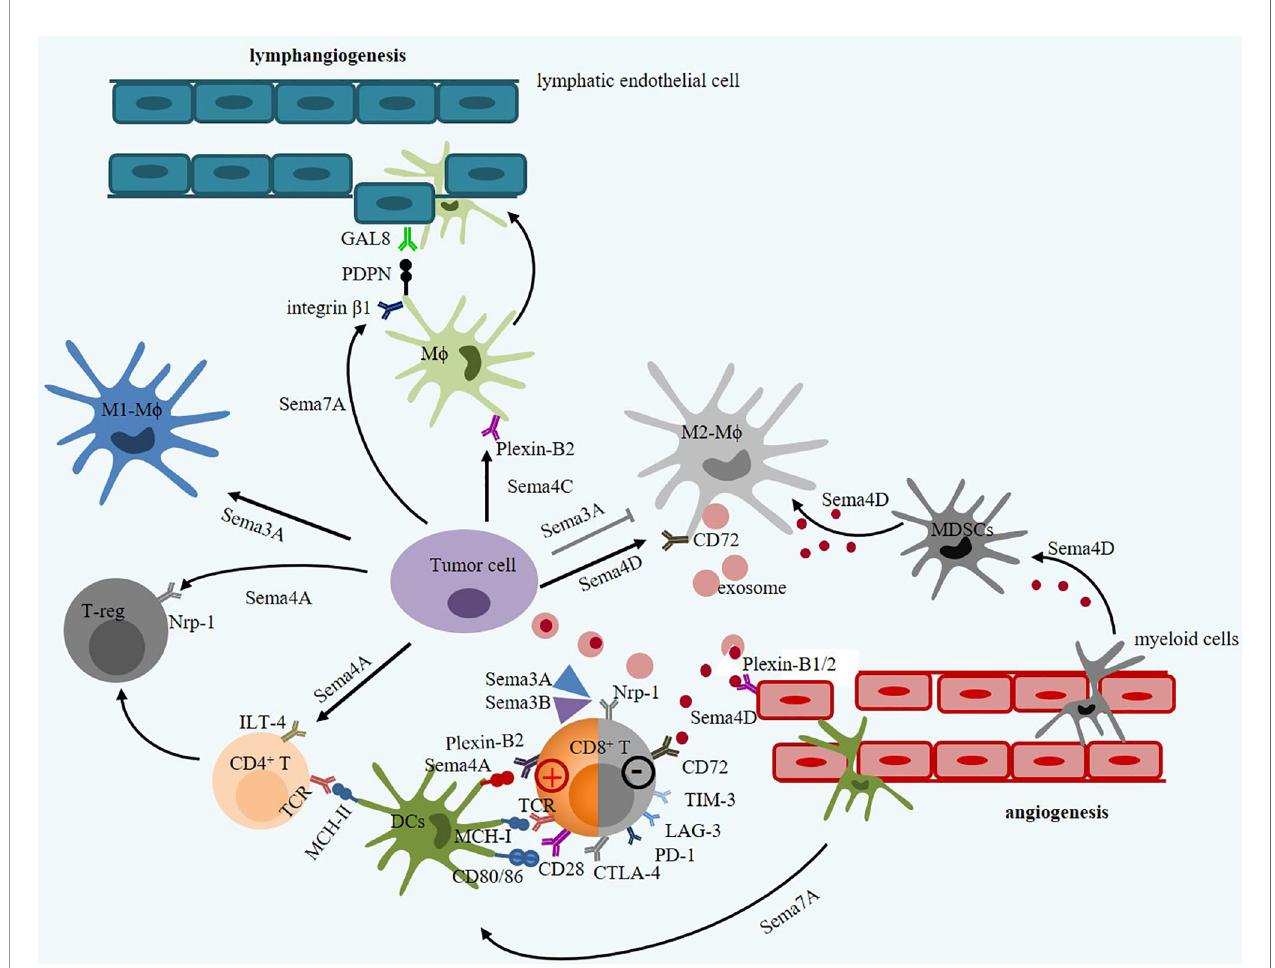
FIGURE 2 | The intricate roles of immune semaphorins and their receptors in tumor microenvironment. Sema3A and Sema3B contribute to decrease in toxicity of CTL by binding to Nrp-1. However, Sema3A promotes M1-M f proliferation but inhibits M2-M f proliferation. Sema4A promotes Treg activation and survival via Nrp1 receptor, but enhance CTL vitality via Plexin-B2 receptor. Sema4D derived from tumor cell or M2-M f promote tumor angiogenesis via Plexin – B1/2 receptor on endothelial cells and inhibit immune response by promoting polarization of MDSCs and inhibiting T-cell function via CD72. Sema4D derived from M f can secrete SDF-1 (CXCL12) that mediates tumor metastasis by binding to CXCR4. Sema7A can mediate macrophages and dendritic cell migration in integrin b 1 signals, and mediate tumor lymphatic metastasis through upregulating PDPN